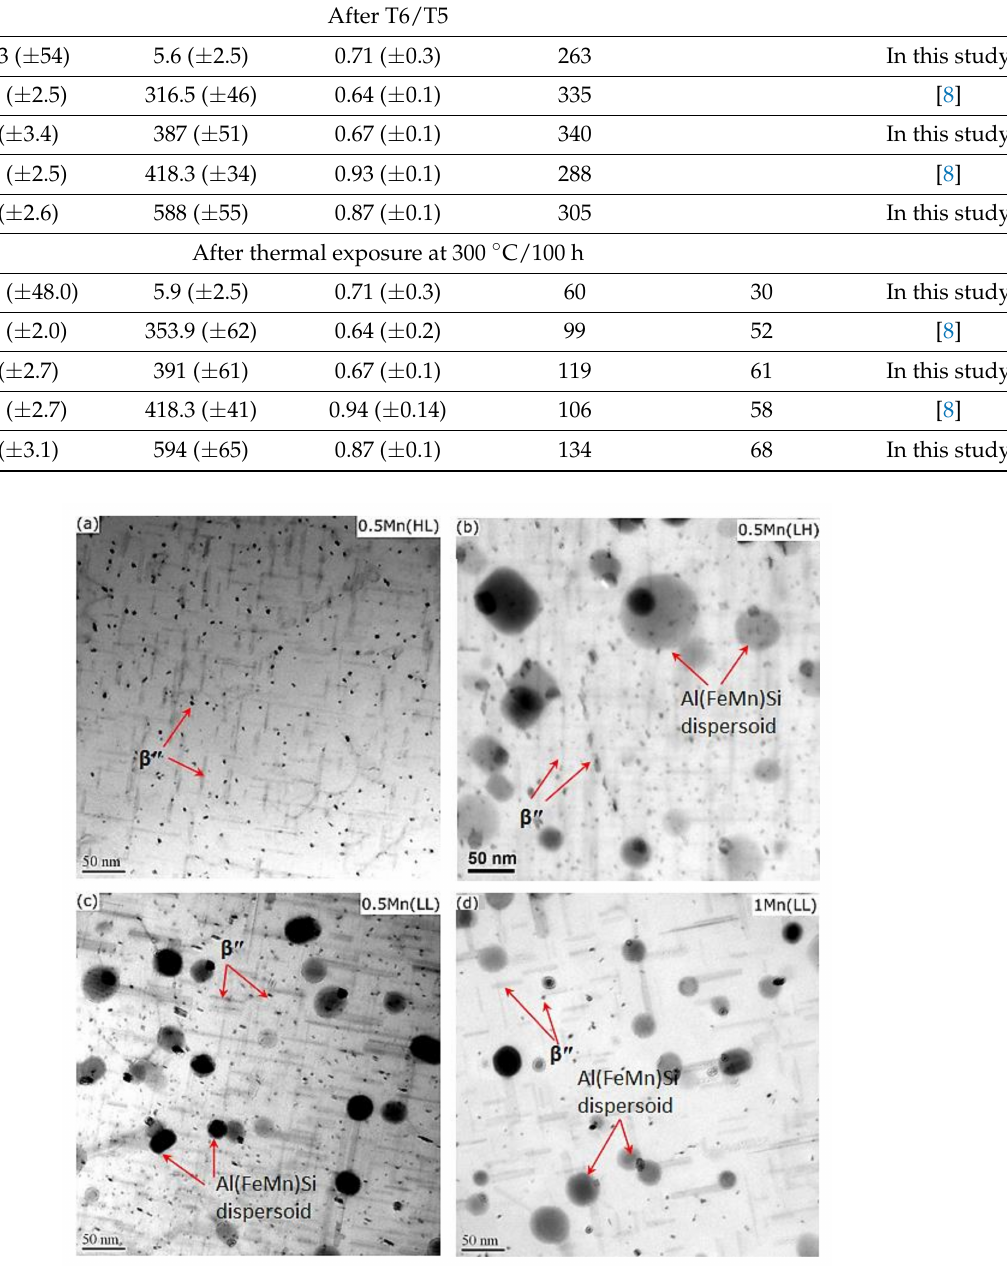
Figure 5. Representative bright-field TEM images showing β (cid:48)(cid:48) precipitates and α -Al(FeMn)Si disper- soids in ( a ) 0.5Mn(HL), ( b ) 0.5Mn(LH), ( c ) 0.5Mn(LL), and ( d )